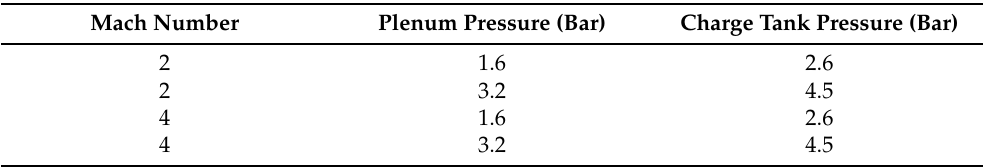
Table 1. Summary of different Mach number and pressure test